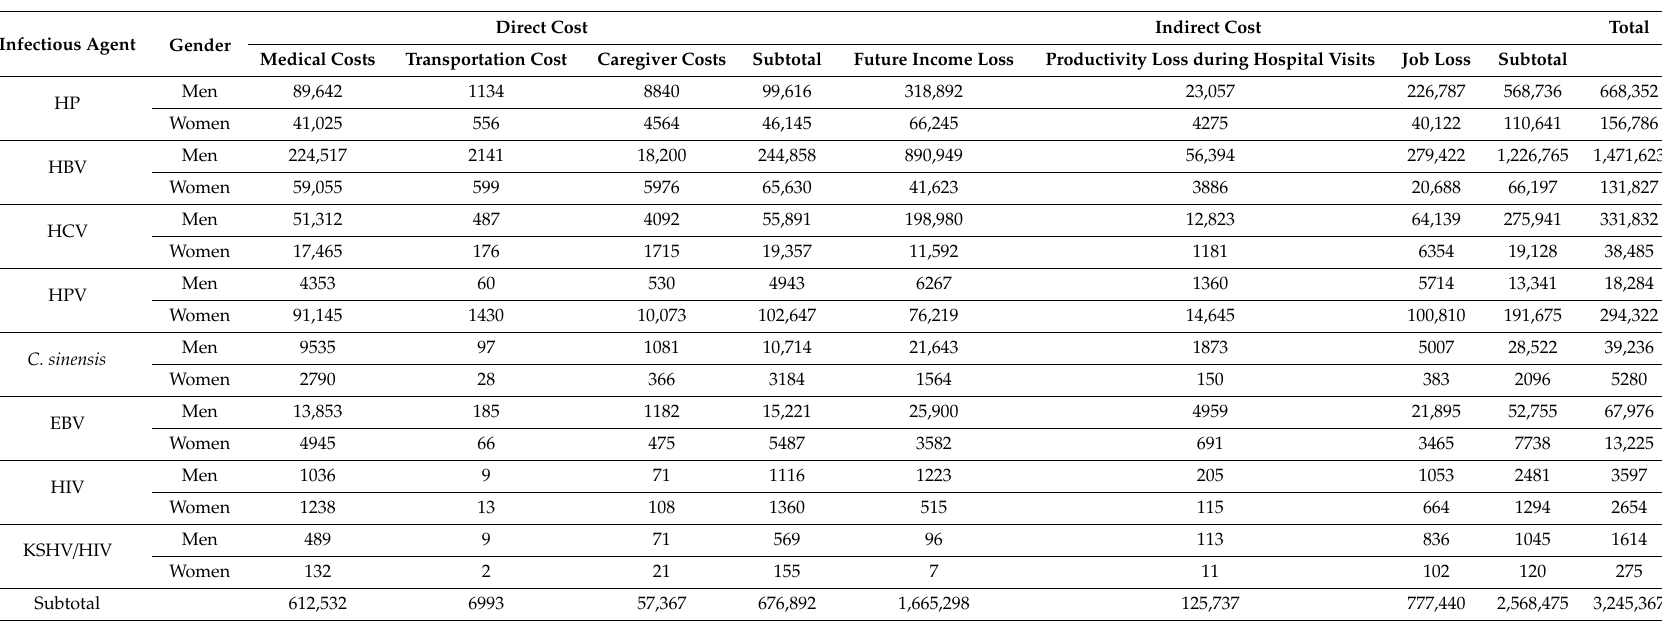
Table 3. Estimated direct and indirect costs of infection-related cancers regarding infectious agent in 2014, South Korea (Unit: 1000 USD). Infectious Agent